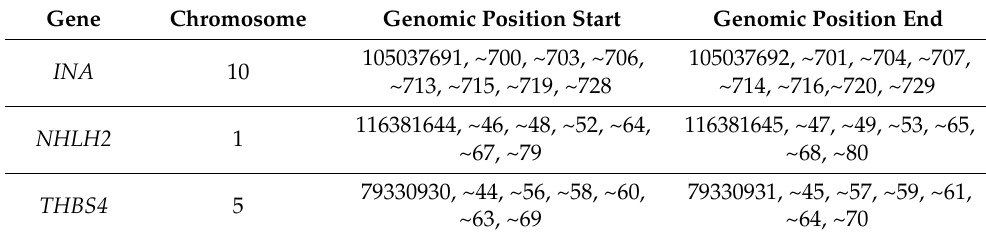
Figure 1. Localization of exons (higher part of orange rectangles) and the genomic regions corre- sponding to the 5’UTR ( INA ( c ), THBS4 ( a ), or 3 (cid:48) UTR ( NHLH2 ( b )) (lower part of orange rectangles) are shown. CpG sites are annotated for the region (CpG sites), as well as the localization of CpG islands (CGI), positions of CpG sites considered in the KIRC study (KIRC), and the localization of pyrosequencing assays used (Assay). The asterisk (*) tags candidate CpG sites identified in the in silico analysis of the KIRC data. Table 2. Genomic position of CpG sites amenable by